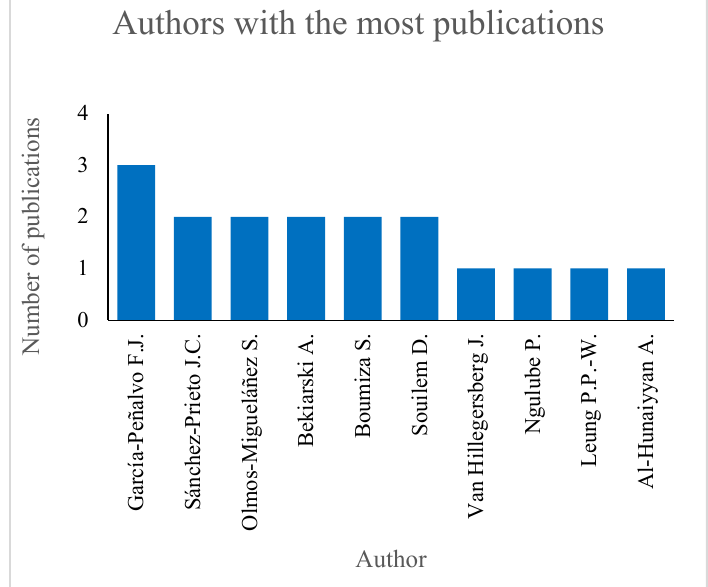
Figure 4. Authors with the greatest number of publications. Own elaboration from SCOPUS data.